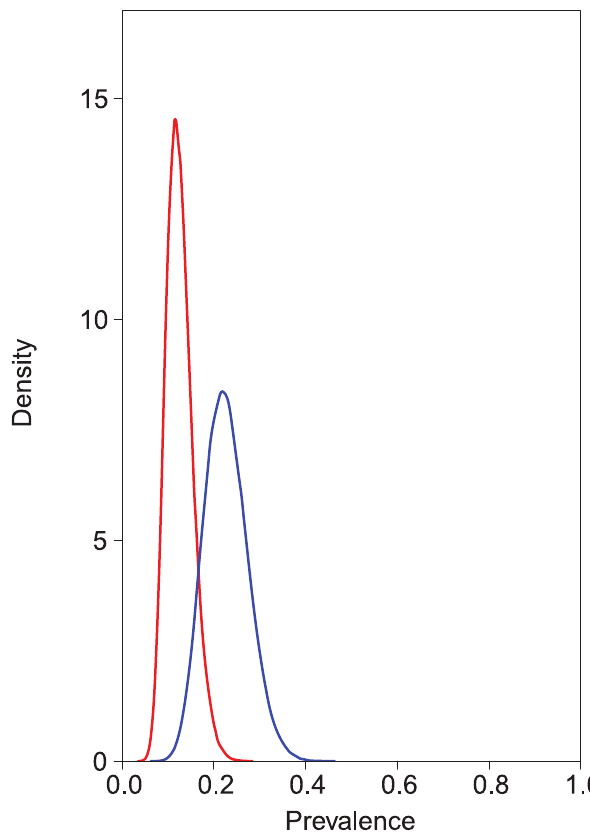
Figure 1. Effect of Taenia co-infection on prevalence of E. multilocularis. Using a Bayesian latent-class model, prevalence of E. multilocularis in Taenia test-negative dogs was estimated at 12.2% (95% credible intervals 7.6–18.9%), and in Taenia test-positive dogs was estimated at 22.3 (95% credible intervals 8.2–47.7%). Taenia co-infection was found to be a significant covariate with E. multilocularis infection (odds ratio 2.06, 95% credible intervals 1.07–3.9). In the figure the posterior distributions of the prevalence of E. multilocularis with (blue) and without (red) Taenia co-infection are shown.